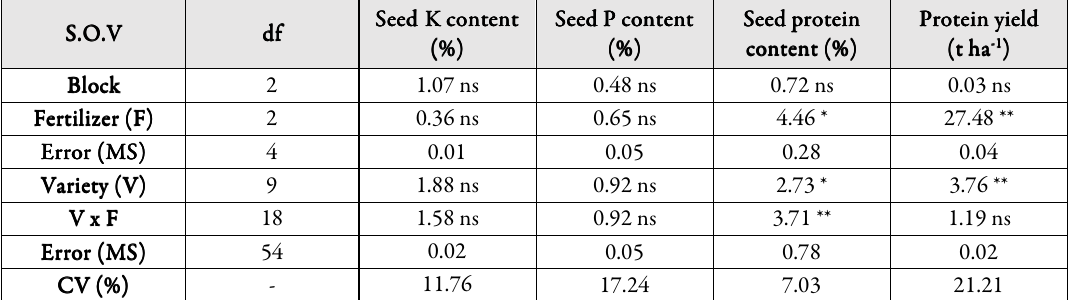
Table 7. Analysis of variances (F) for the effect of fertilization and different wheat varieties on seed qualitative parameters